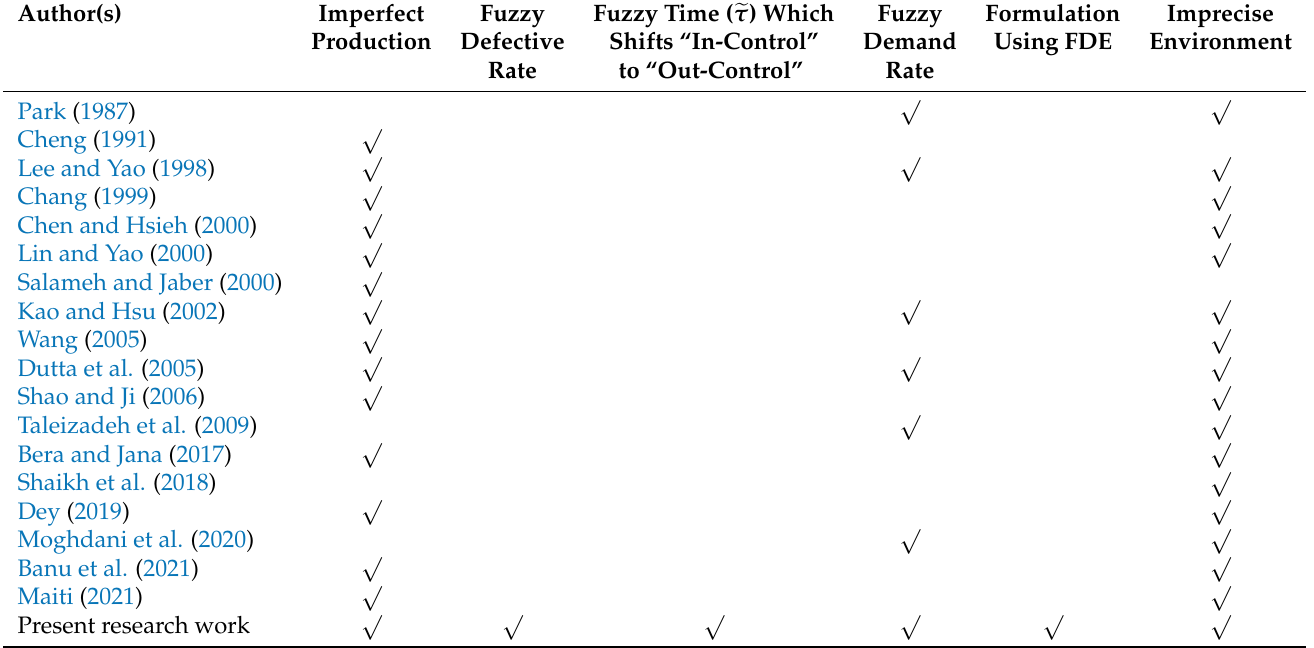
Table 1. Major characteristics of imperfect production inventory models on selected